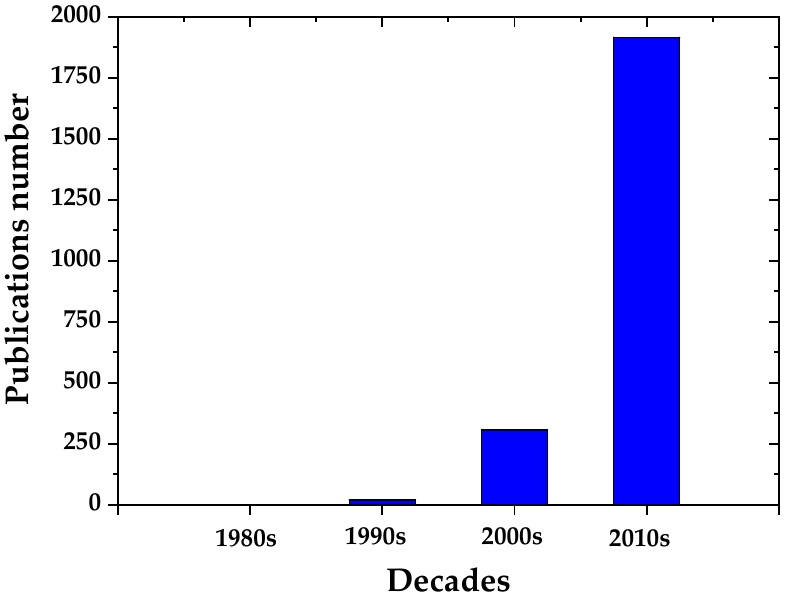
Figure 1. Publications on nanotechnology in cementitious composites per decade.